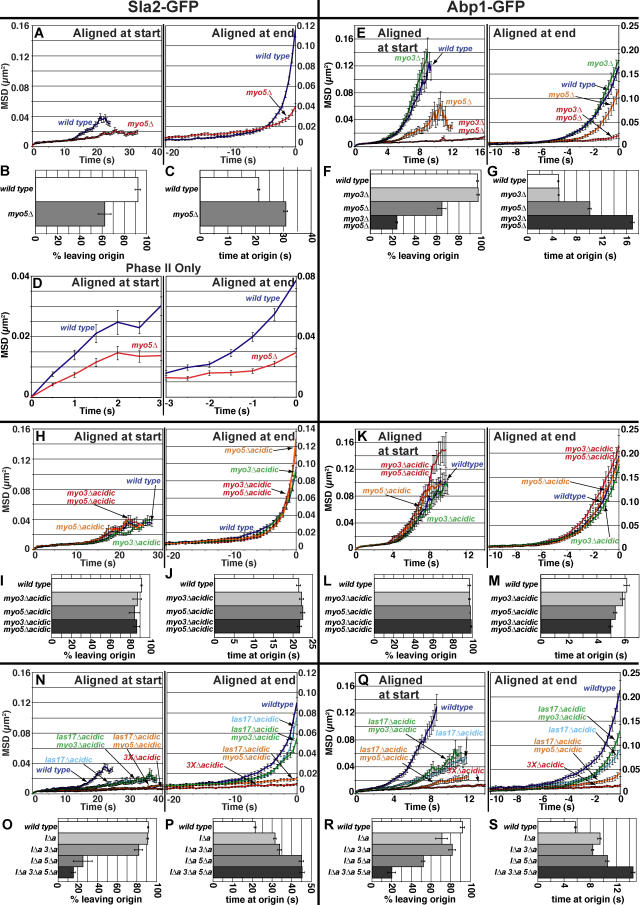
Quantitative Motion Analysis of Actin Patches in Type-I Myosin Mutants(A–G) Null mutants lacking one or both type-I myosin. Cells express Sla2-GFP (A–D) or Abp1-GFP (E–G). (A) MSD plots for wild-type and myo5Δ patches aligned at the start (left) or end (right) of their lifetimes. The curves on the left are truncated at the median lifetime. (B) Percentage of patches that leave the origin. Mean of values for three segregants is shown. (C) Average time at the origin, from the appearance of a patch until it moved away or disappeared. (D) Phase II movement only. For each patch, data prior to movement were removed. (E) MSD plots for wild-type and mutant patches aligned at the start (left) or end (right) of their lifetimes. On the left, plots are truncated at the median lifetime or 16 s, whichever was less. (F) Percentage of patches that leave the origin, as in (B). (G) Average time at the origin, as in (C).(H–M) Mutants lacking Arp2/3-binding regions of one or both type-I myosins, termed myo3Δacidic and myo5Δacidic. The panels are similar to those above, with cells expressing Sla2-GFP (H–J) or Abp1-GFP (K–M). (H and K) MSD plots for wild-type or mutant patches aligned at the start (left) or end (right) of their lifetimes. The curves on the left are truncated at the median lifetime. (I and L) Percentage of patches that leave the origin. Mean of values for three segregants is shown. (J and M) Average time at the origin, from the appearance of a patch until it moved away or disappeared.(N–S) Mutants lacking Arp2/3 binding regions of WASp/Las17 and type-I myosins. Cells express Sla2-GFP (N–P) or Abp1-GFP (Q–S). (N and Q) MSD plots for wild-type or mutant patches aligned at the start (left) or end (right) of their lifetimes. The curves on the left are truncated at the median lifetime. (O and P) Percentage of patches that leave the origin. Mean of values for three segregants is shown. (R and S) Average time at the origin, from the appearance of a patch until it moved away or disappeared.Strain numbers and number of patches: (A–C) Wild-type, YJC4787–9; 94, 79, and 90. myo5Δ, YJC4784–6; 103, 79, and 69. (D) Strains as in (A–C). Numbers of patches: wild-type – 88, 69, 85. myo5Δ – 75, 40, 36. (E–G) Wild-type, YJC4815–7; 121, 110, and 130. myo3Δ, YJC4409–11; 111, 115, and 105. myo5Δ, YJC4813–4; 120 and 99. myo3Δ myo5Δ, YJC4770–2; 143, 141, and 126. (H–J) Wild-type, YJC5566–8; 71, 107, and 83. myo3Δacidic, YJC5563–5; 71, 75, and 101. myo5Δacidic, YJC5554–6; 86, 71, and 62. myo3Δacidic myo5Δacidic, YJC5557–9; 83, 65, and 83. (K–M) Wild-type, YJC4848 and 50; 116 and 87. myo3Δacidic, YJC4843–5; 119, 99, and 106. myo5Δacidic, YJC4840–2; 102, 111, and 99. myo3Δacidic myo5Δacidic, YJC4837–9; 96, 93, and 100. (N–P) Wild-type, YJC5566–8; 71, 107, and 83. las17Δacidic, YJC5551–3; 84, 64, and 69. las17Δacidic myo3Δacidic, YJC5560–2; 89, 71, and 68. las17Δacidic myo5Δacidic, YJC5548–50; 51, 66, and 57. las17Δacidic myo3Δacidic myo5Δacidic, YJC5545–7; 43, 53, and 54. (Q–S) las17Δacidic, YJC5208–10; 95, 76, and 89. las17Δacidic myo3Δacidic, YJC5438–40; 111, 104, and 109. las17Δacidic myo5Δacidic, YJC5441–3; 98, 80, and 84. las17Δacidic myo3Δacidic myo5Δacidic, YJC5205–7; 71, 79, and 99.